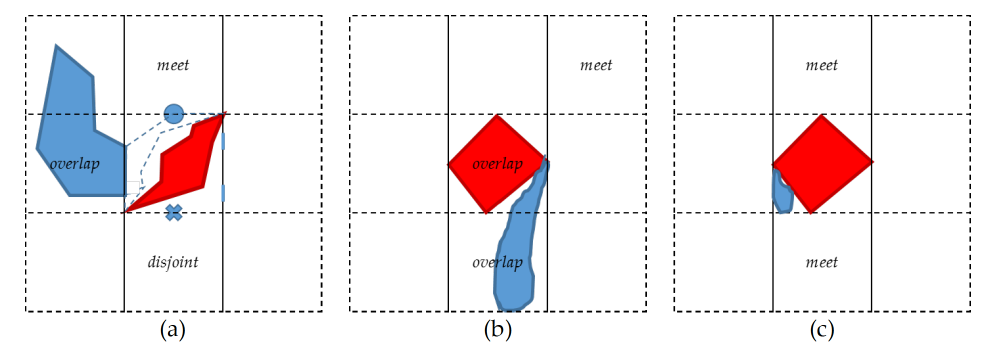
Figure 11: Three possible cases from Rule 4.7: (a) Rule 4.7.1, (b) Rule 4.7.2, and (c) Rule 4.7.3. In (a), the object presents a barrier to attaining the slots necessary on both sides of the MBR. In (b), the object again creates a barrier to reaching the opposite side of the MBR as it cannot enter the two tiles that share an edge with it. Finally, in (c), the object again precludes the crossing as the object is not allowed to leave the tile in this case in any